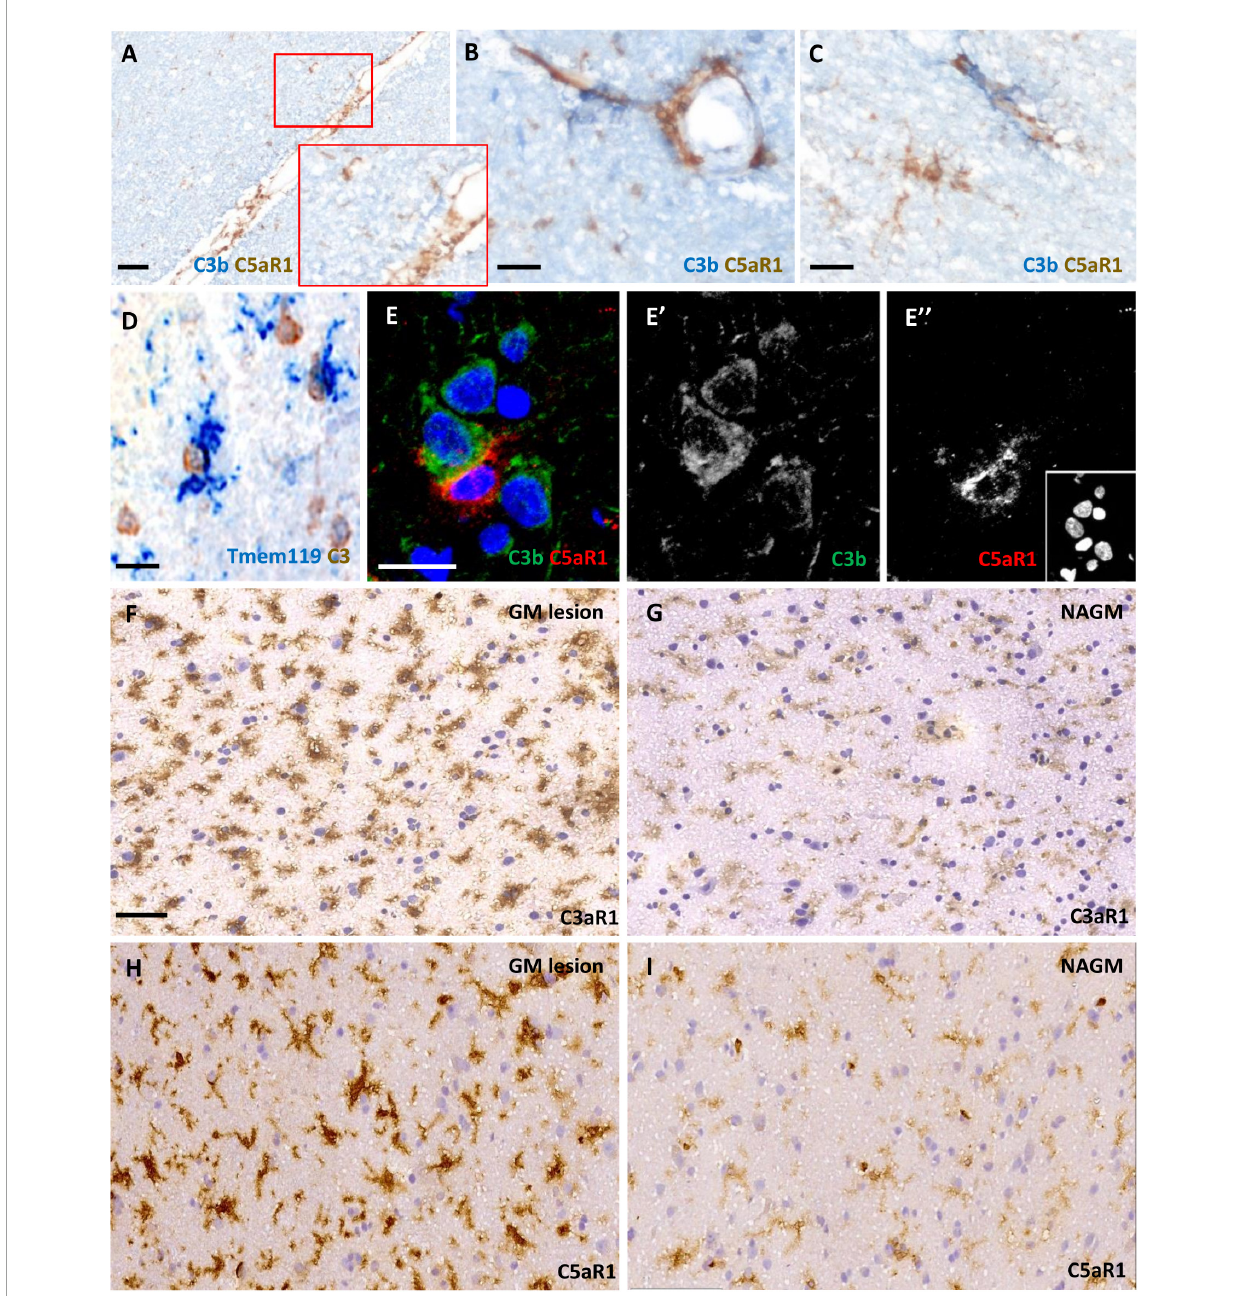
FIGURE3 Anaphylatoxin receptor expression at sites of complement activation. Complement C3b (blue reaction product) and C5aR1 + cells (brown reaction product) and subpial and perivascular sites of the cortical GM (A–C) . TMEM119 + immunopositive microglia (blue) in close contact with large neuron-like cells expressing C3 transcript (D) and an example of a C5aR1 + cell contacting a C3b immunoreactive cortical neuron (E–E”) . Immunostaining revealed an elevated number and more darkly stained C3aR1 and C5aR1 + cells with a microglia-like morphology in the demyelinated cortical GM (GM lesion; F,H ) in comparison to adjacent normal appearing GM (NAGM; G,I ). Scale bars; panels (A,F–I) = 50 µ m and panels (B–E”) = 20 µ